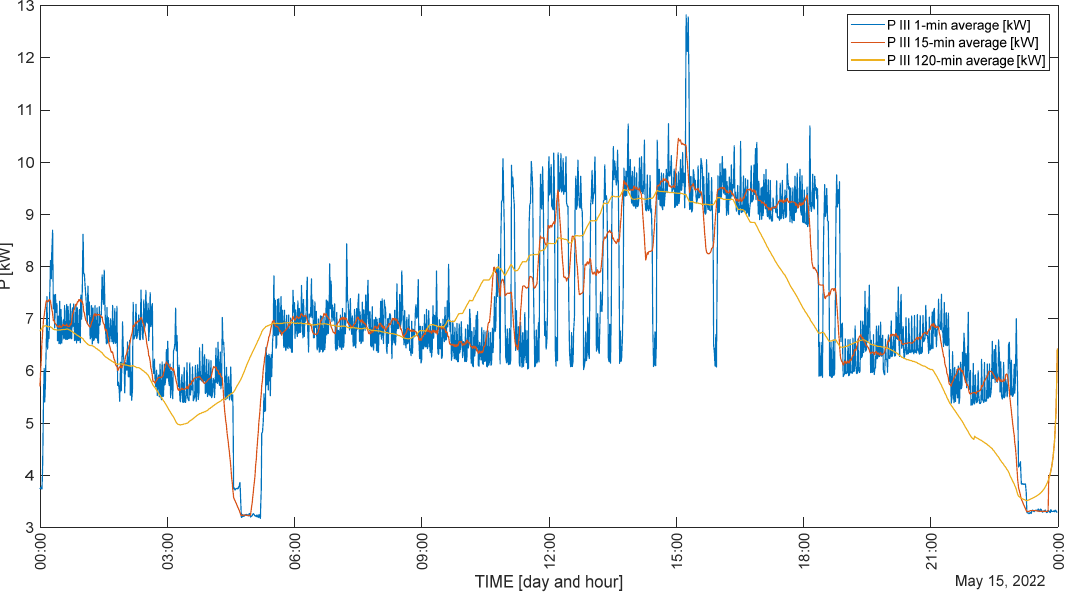
Figure 11. Three-phase active power as a function of time on a representative day of the 3rd stage.